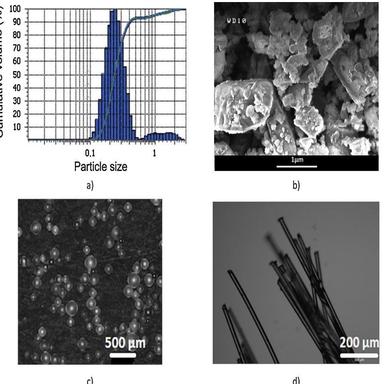
Starting materials: a) grain size distribution of the SiC powder, b) secondary electrons image (magnification x30000) of the SiC powder; c) optical microscopy (magnification x5) of the PMMA balls and d) optical microscopy (magnification x5) of the LLDPE fibers.